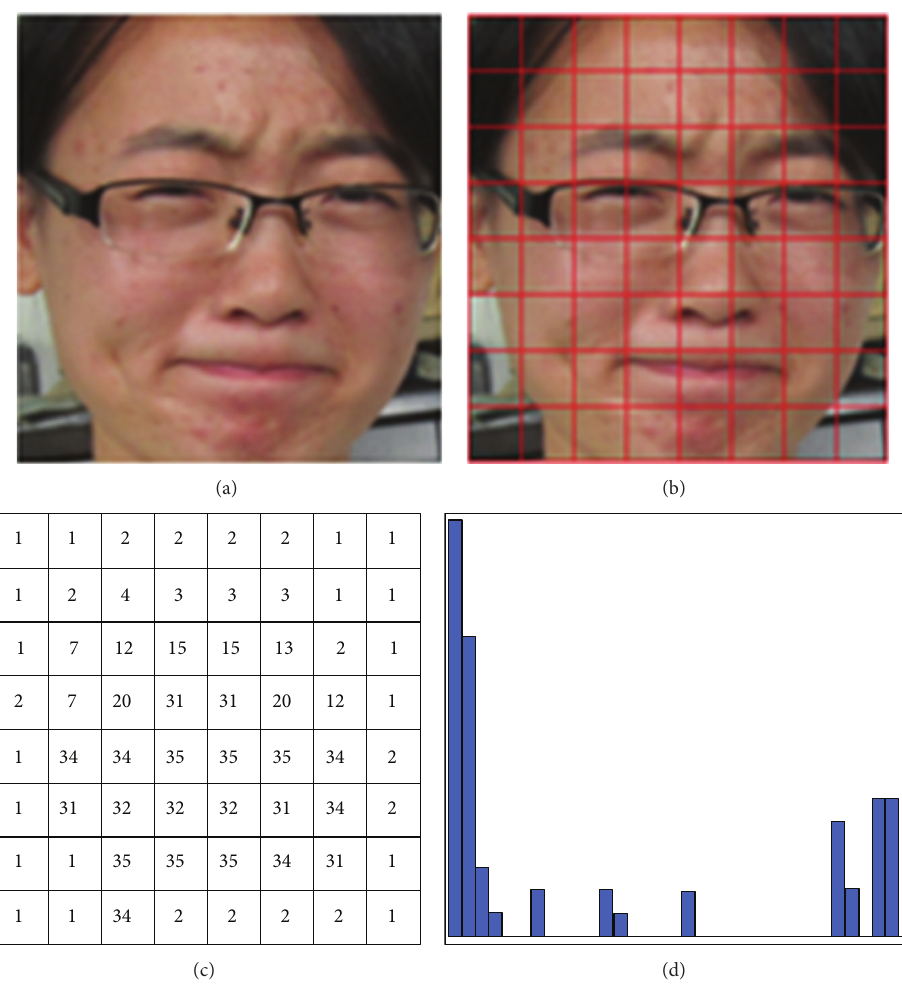
Figure 1: The processing pipeline of the “bag-of-words” representation: (a) give an image, (b) divide into 𝐿 × 𝐿 blocks, (c) represent each block by a “visual word,” and (d) ignore the ordering of words and represent the facial image as a histogram over “visual words.”